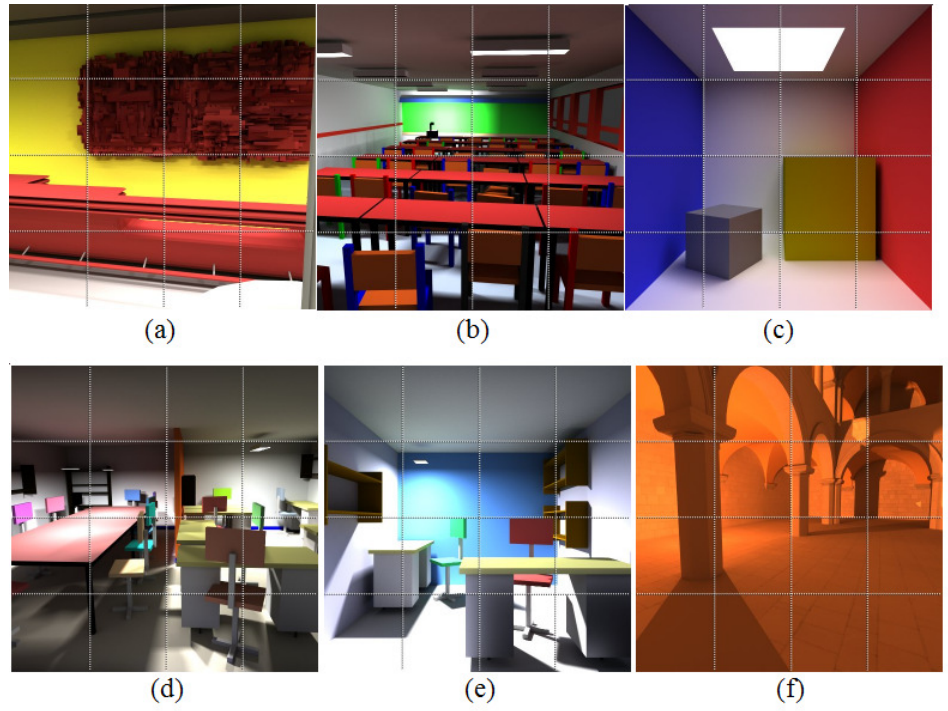
Figure 1. Rendering results for the sub-images of the scenes with 512 × 512 resolution. The scenes with 512 × 512 resolution ( a – f ) consist of diffuse surfaces with complex geometry. They contain objects with different material properties presenting rich and complicated shading variations under different lighting conditions.